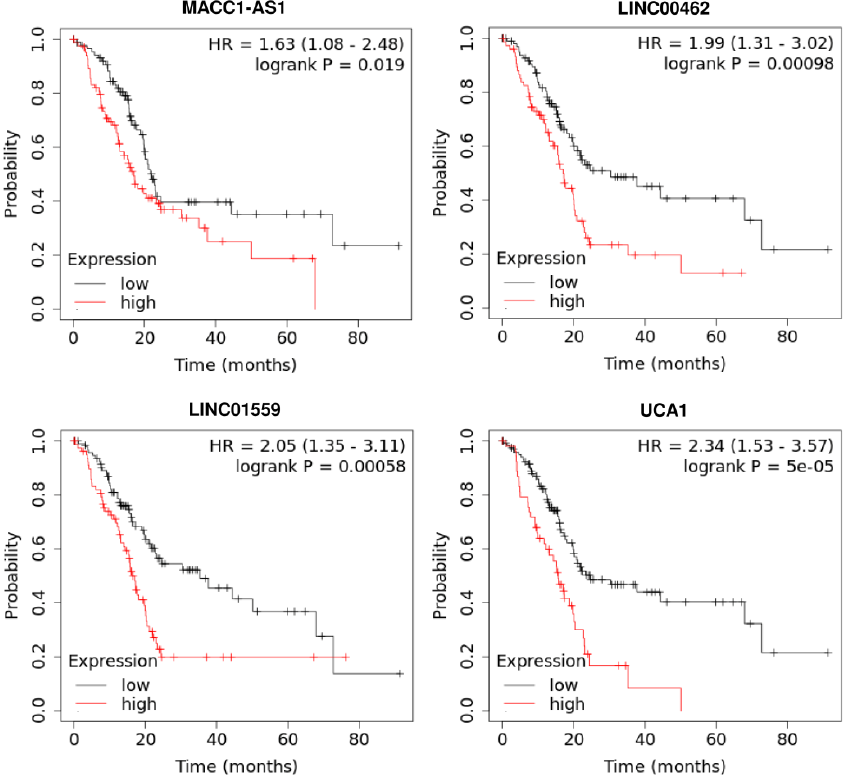
Figure 4. The prognostic value of lncRNA MACC1-AS1, LINC00462, LINC01559, and UCA1 in pancreatic cancer patients was investigated using the KM-plotter